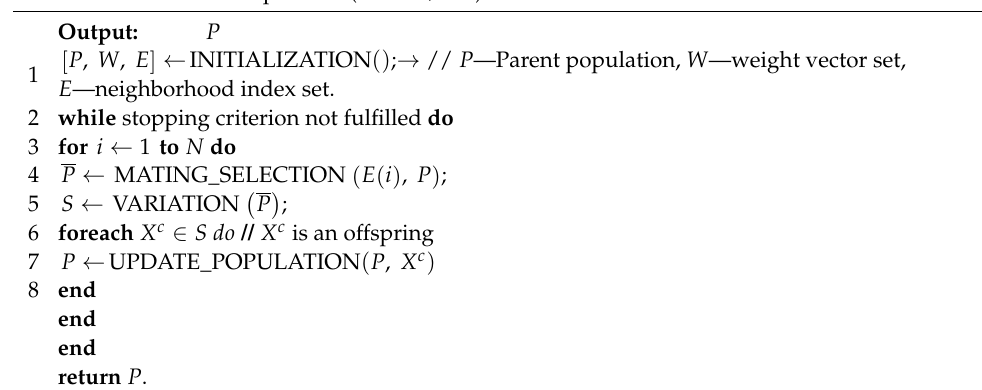
Algorithm 2: General Framework of multi-objective evolutionary algorithm based on both dominance and decomposition